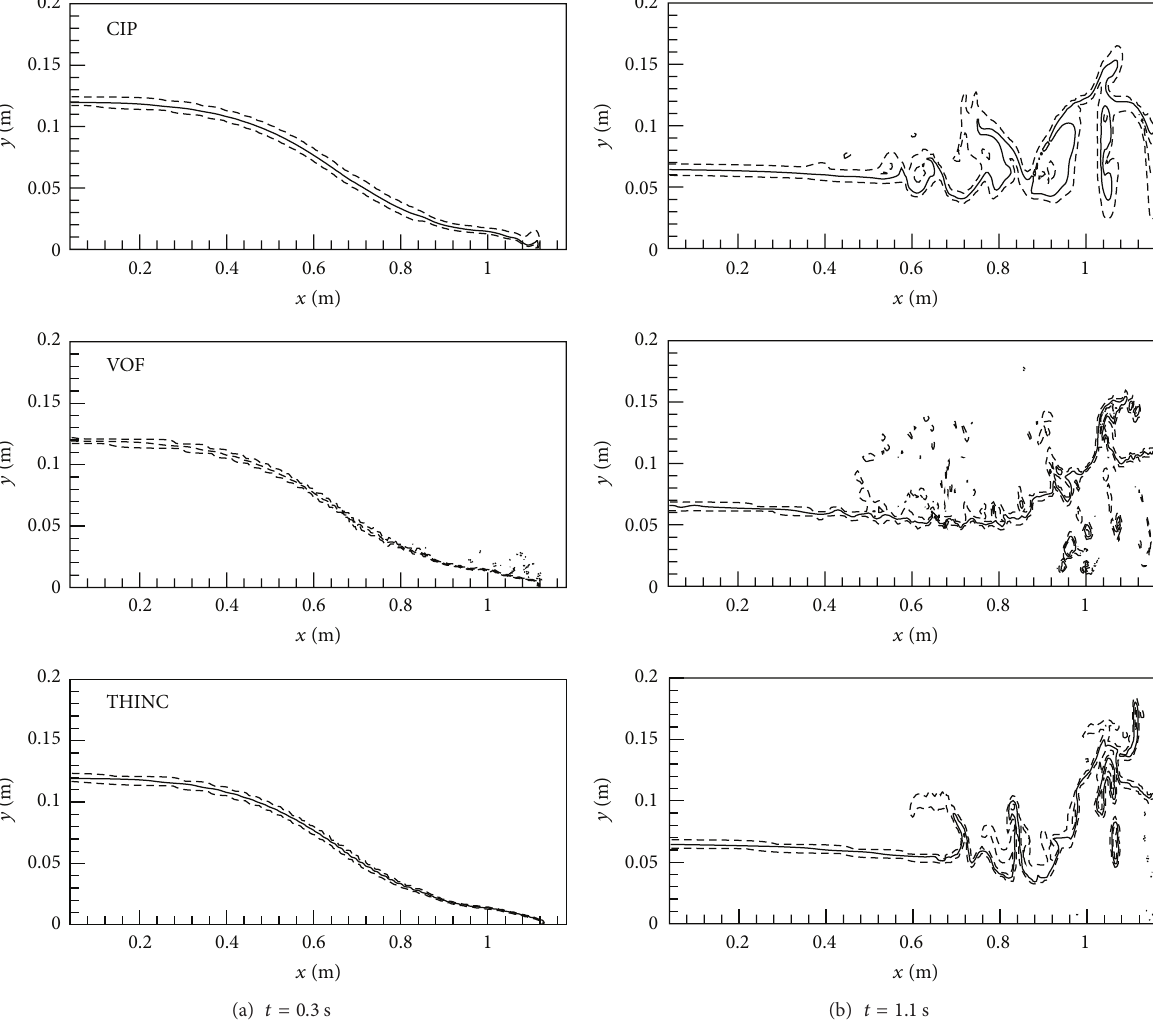
Figure 3: Comparison of density function contours at 𝑡 = 0.3 s (a) and 1.1s (b). The three lines indicate that 𝜙 = 0.05 , 0.50, 0.95. The interface-capturing scheme is CIP (up), VOF (middle), and THINC (down).